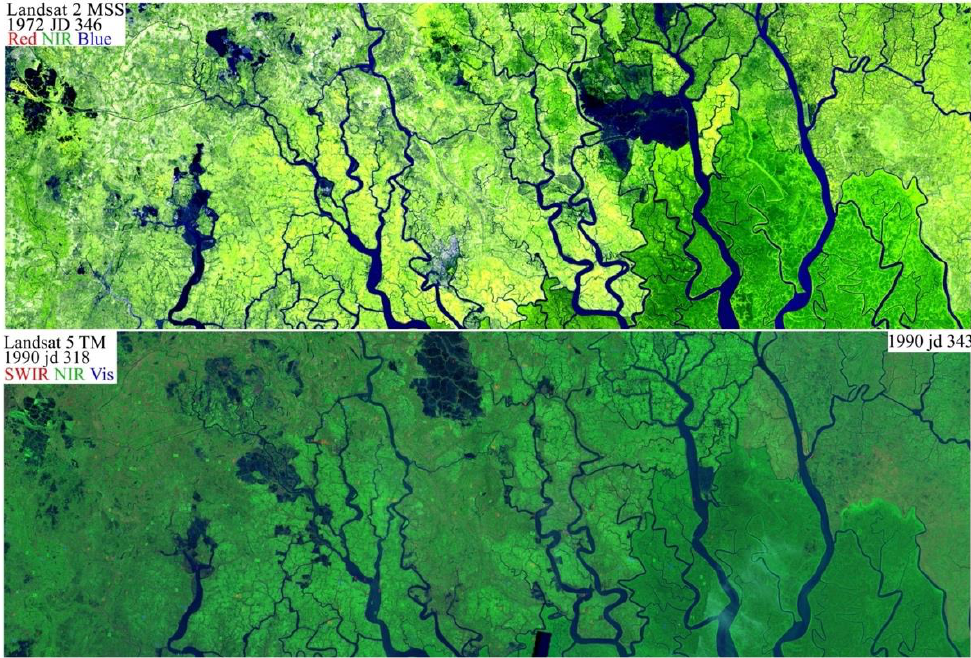
Figure 6. Comparison of 1972 and 1990 land cover on the lower GBD. The 1972 image was acquired by Landsat 2 MSS. This instrument did not image in the SWIR and is not so rigorously intercalibrated as the later Landsat 4 – 8 TM/ETM+/OLI imagery. Both images are false color composites. For the Landsat 2 image, red = visible red reflectance; green = NIR reflectance; blue = visible blue reflectance (MSS bands 5, 6, and 4). For the Landsat 5 image, red = SWIR reflectance; green = NIR reflectance; blue = visible reflectance (TM bands 6, 4, and 2). The images were enhanced so as to be visually comparable, but the enhancements are not identical so the colors cannot be directly related across images. Regardless, broad-scale land cover can be assessed. While exceptions exist, there is clearly at least as much standing water in 1972 as in 1990. Few large, spatially coherent regions of standing water can be identified in 1990 that do not also exist in 1972. Systematic, widespread expansion of aquaculture before 1990 is not apparent.